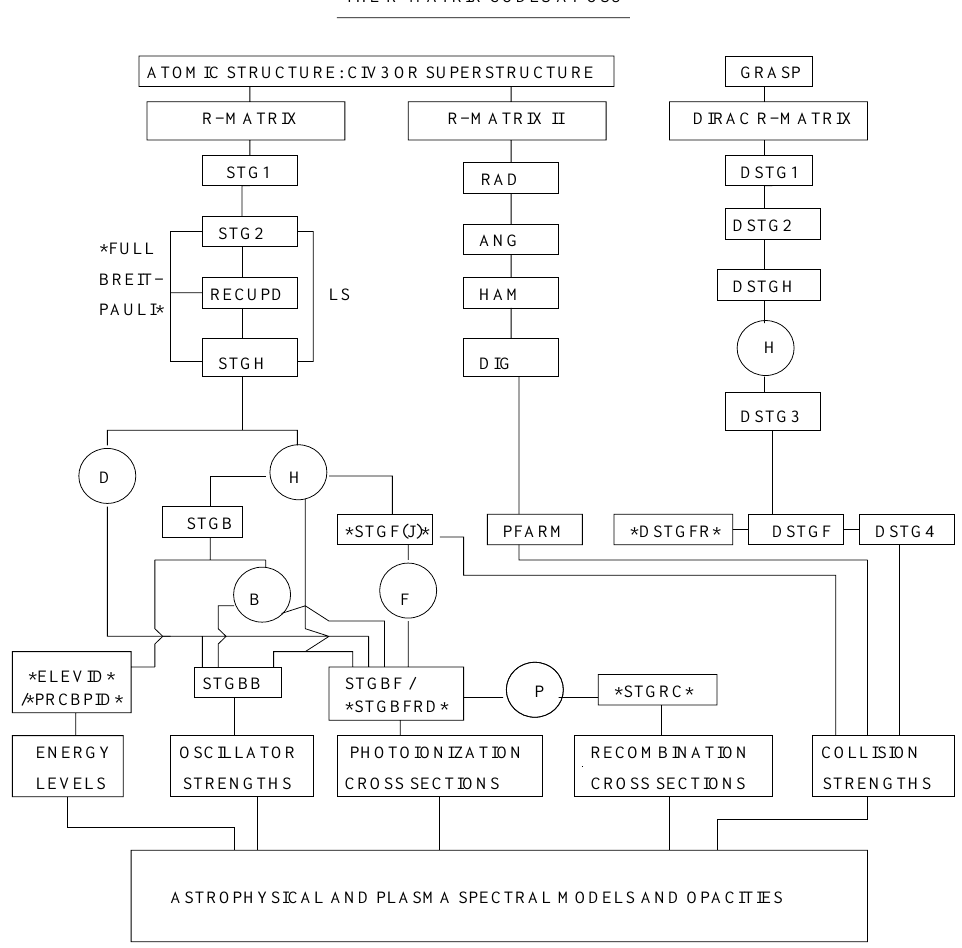
Figure 1. The R-matrix codes for opacities calculations (codes with * were developed or extended at OSU). Atomic data produced are further processed via a suite of equation-of-state, plasma broadening, and opacity codes to obtain monochromatic and mean opacities at each temperature and density